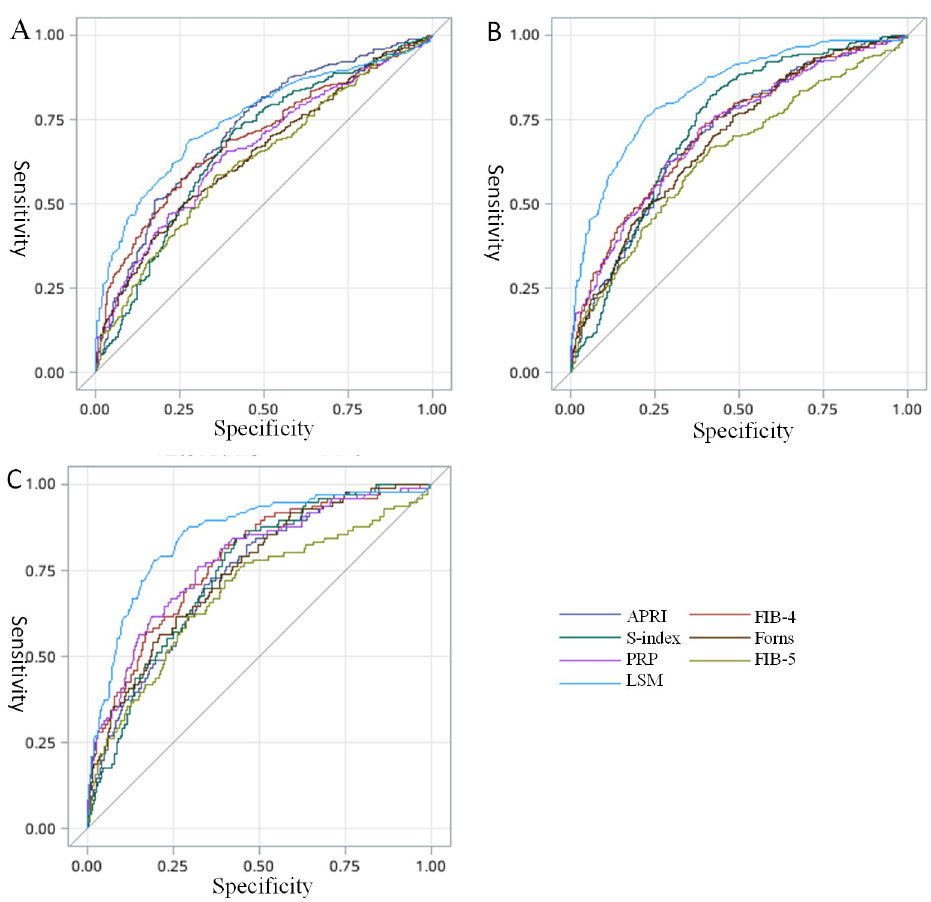
Fig 2. Effects of FibroTouch and six serological models on the staging of liver fibrosis using ROC curve. A: ROC curve of patients with liver histopathological stage S � 2; B: ROC curve of patients with liver histopathological stage S � 3; C: ROC curve of patients with liver histopathological stage S =